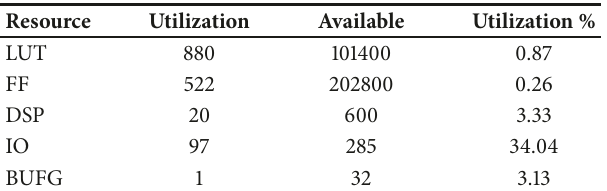
Table 1: Resources consumed by the FPGA implemented of pro- posed autonomous jerk